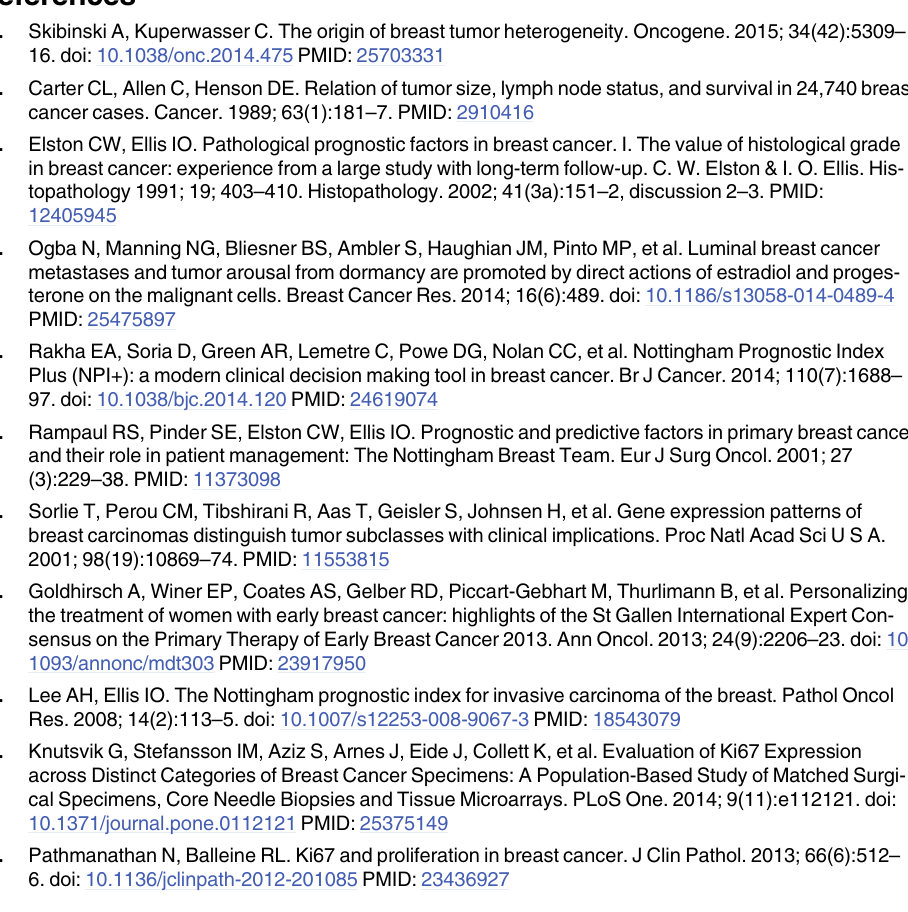
S2 Table. Clinico-pathologic characteristics of primary tumors for the study cohort. Clin- ico-pathologic characteristics of primary tumors for the cases which were finally included in this study ( n = 168). S3 Table. Data-sheet for cases used in this